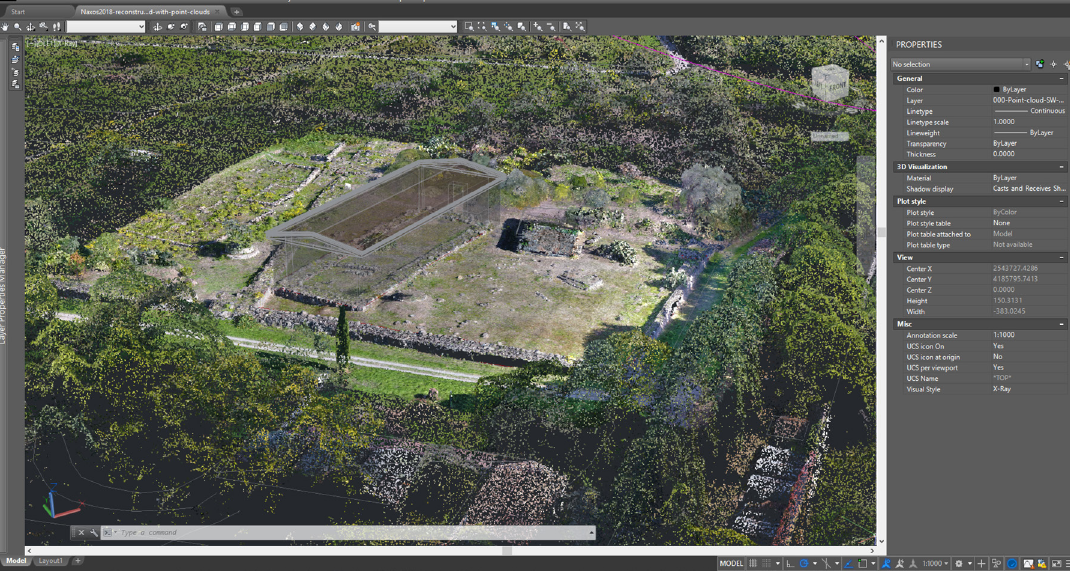
Figure 9. Temple B. Textured three-dimensional model of the geison revetment and lateral anthemion sima (Series A, B and C) fragments with reconstruction drawing superimposed on the model on the left (Jari Pakkanen).